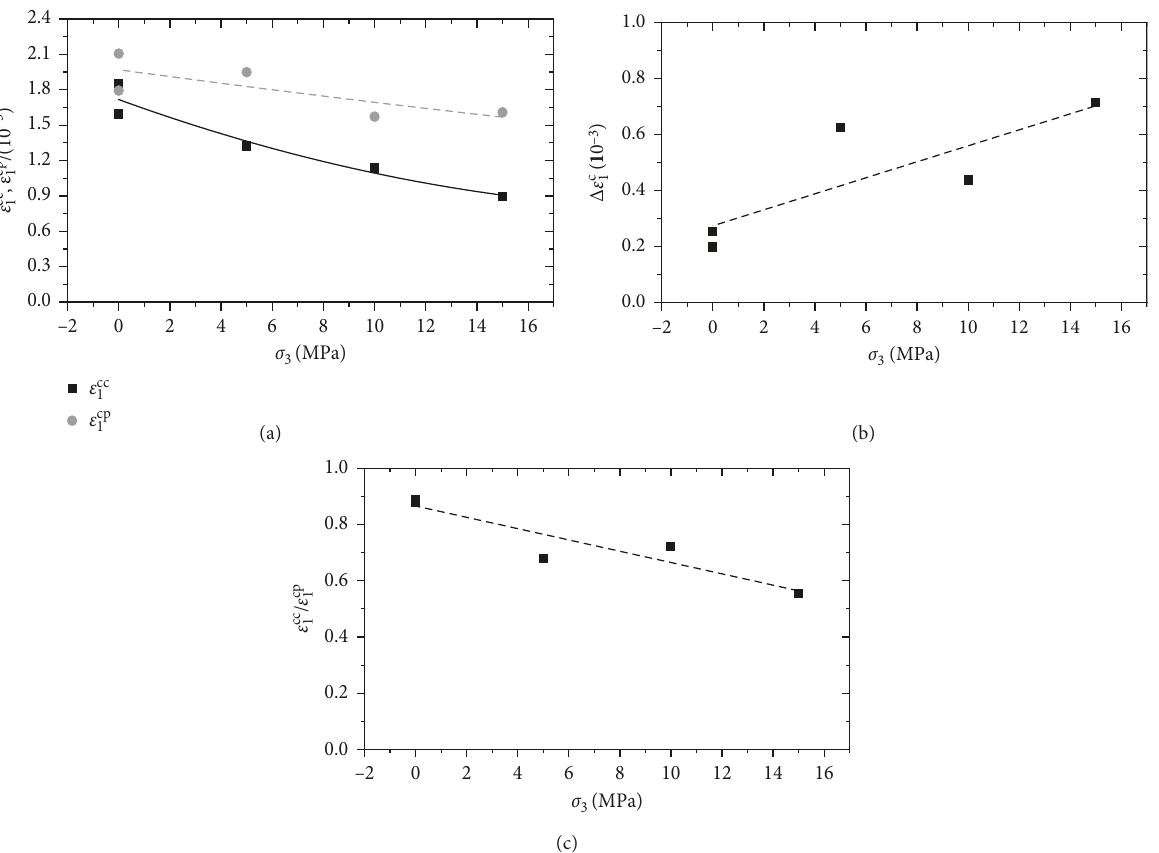
; (b) relationship between Δ ε c 3